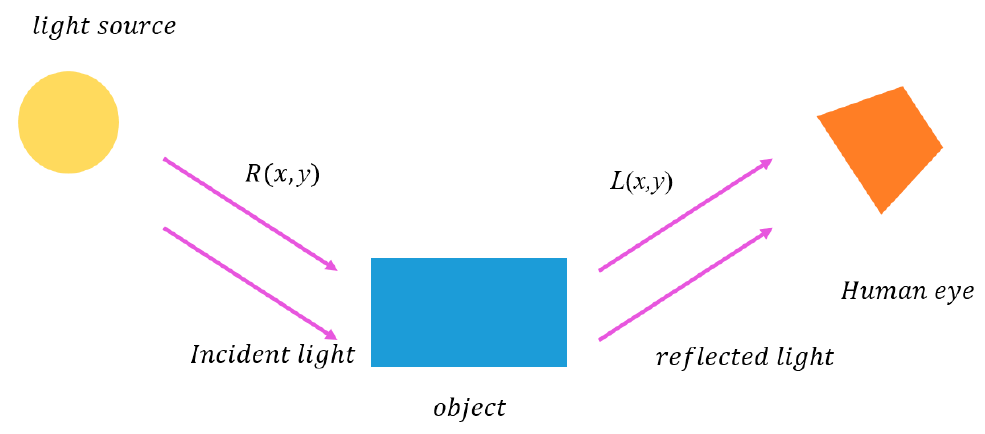
Figure 2. Retinex algorithm light decomposition diagram.